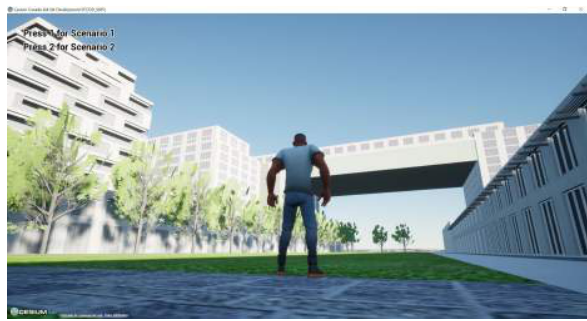
Figure 9. Area with to be developed Buildings